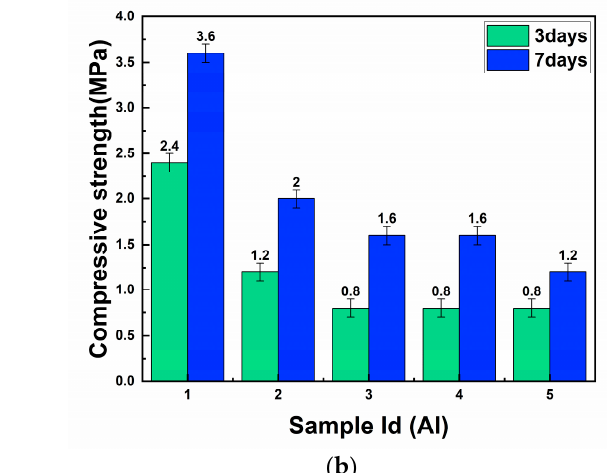
Figure 7. Effect of curing time on the compressive strength of porous geopolymers. ( a ) H 2 O 2 foaming and ( b ) Al foaming.